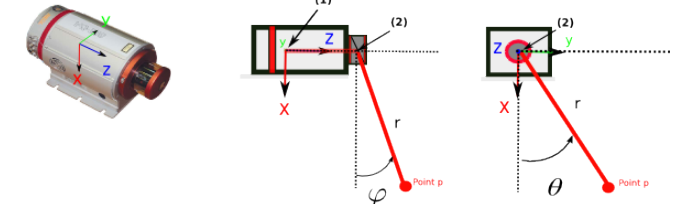
Figure 2: (1) Center of LiDAR frame - (2) The mirror center offset of the LiDAR instrument P LiDAR